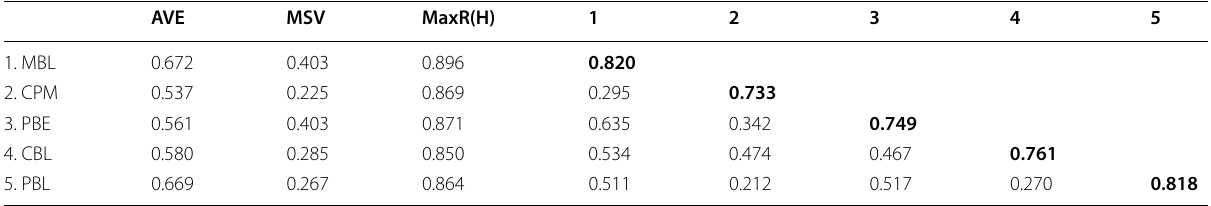
Table 3 Discriminant validity through Fornell–Larcker procedures